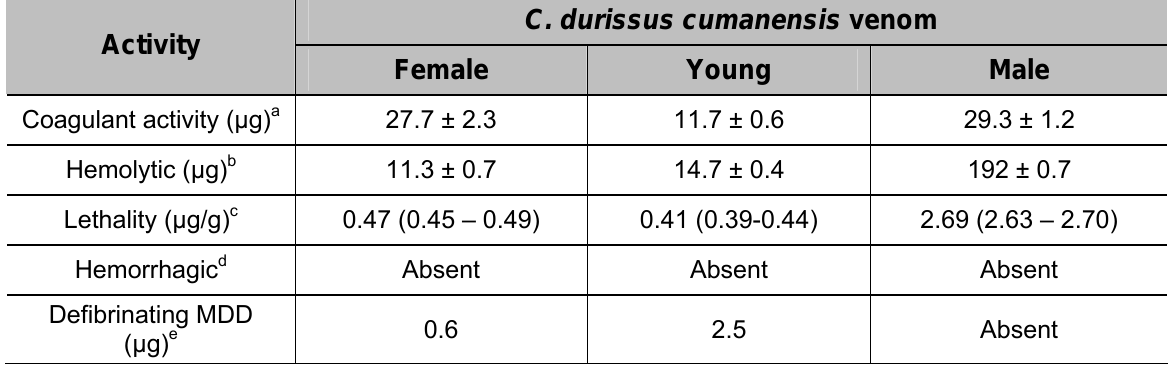
Table 1. Functional activities of C. durissus cumanensis